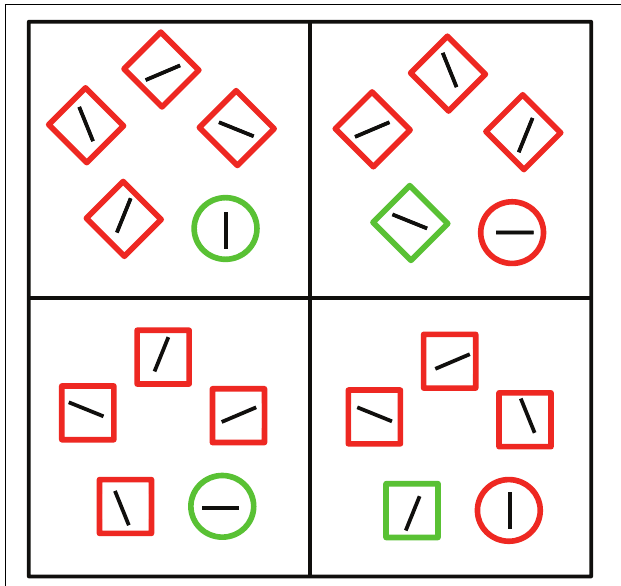
FIGURE 1 | Examples of the four trial types present in Experiment 1. Participants were always instructed to search for the unique circle in the display. The left side depicts congruent trials, in which the target shape was also a color singleton. The right side depicts incongruent trials, in which one of the distractor shapes was also a color singleton. Images are not to